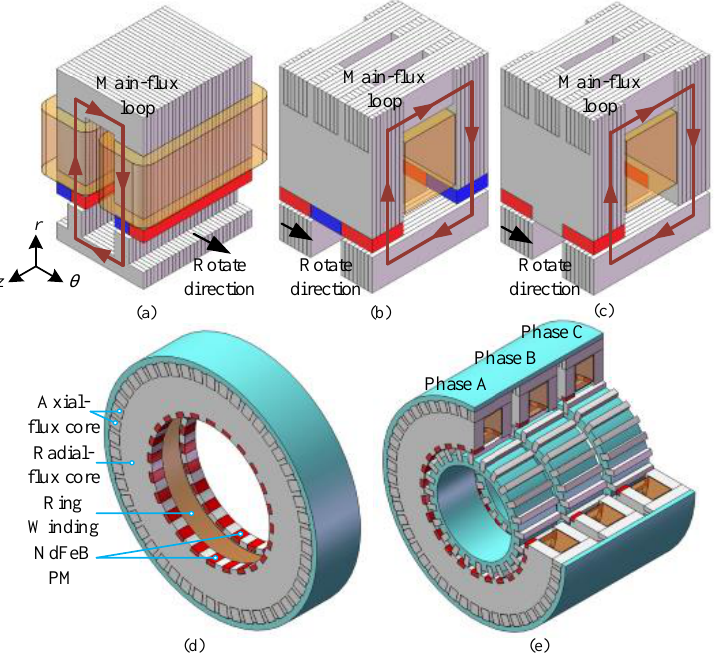
Figure 1. Fundamental structures. ( a ) FRM, ( b ) TF − FRM, ( c ) proposed TF − CFRM, ( d ) stator of single-phase unit of TF − CFRM, and ( e ) structure of three-phase TF − CFRM.